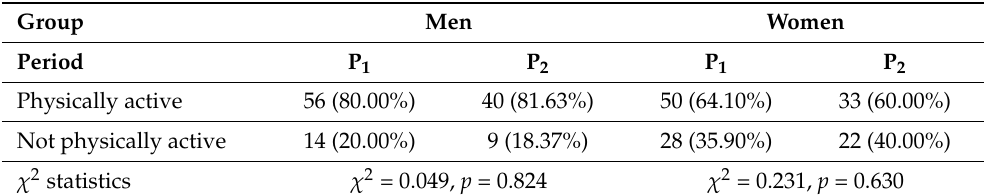
Table 1. Numbers (percentages) of the physically active and non-active students. Pearson’s χ 2 test results.